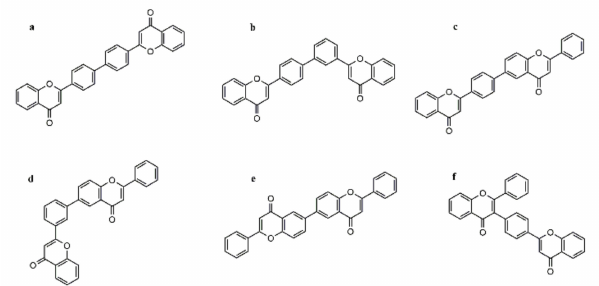
Figure 14. The structure of C-C 4 (cid:48) -4 (cid:48) linkage biflavonoids. However, due to the low yield of the above method, it is impossible to obtain high- yield biflavonoids on a large scale; as a result, researchers have found other ways to synthesize C-C type biflavonoids. Brominated, iominated, or chlorine substituted flavones (S7) and commercially available bis(pinacolato) diboron are reacted to obtain the cor- responding pinacolato boronates (S8), and then S8 (120 mol%) and S7 under standard conditions (Pd(PPh 3 ) 4 (5 mol%), NaOH (400 mol%), and DMF-water (9:1), 100 ◦ C) are reacted to obtain C-C biflavones. R1, R2, R3, R4, R (cid:48) 1, R (cid:48) 2, R (cid:48) 3, and R (cid:48) 4 are the positions attacked by brominated, iominated, chlorine, or bis(pinacolato) diboron. Moon et al., adjusted the reaction conditions to catalytic PdCl 2 (dppf) and K 2 CO 3 in DMF at 90 ◦ C, to reduce the loss of products [329] (Scheme